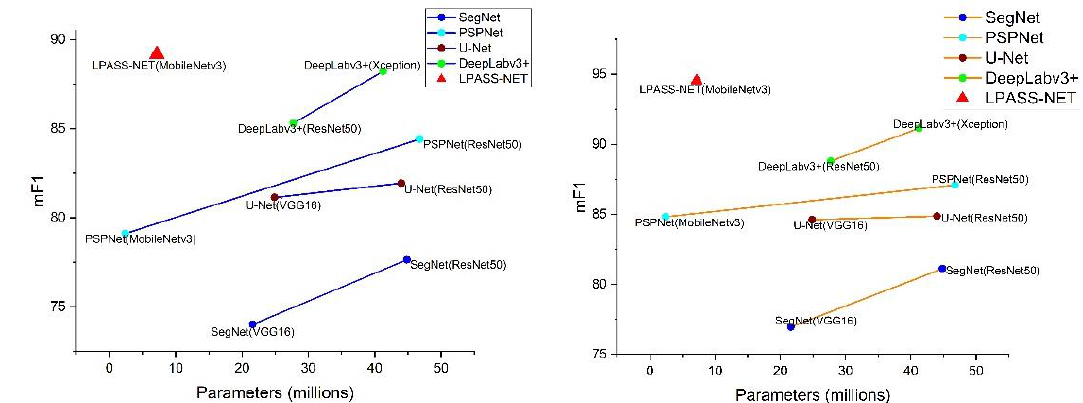
speed compared to DeepLabv3+ when reaching the same mIoU level. This shows that our proposed LPASS-Net can achieve high segmentation accuracy with a smaller model size.